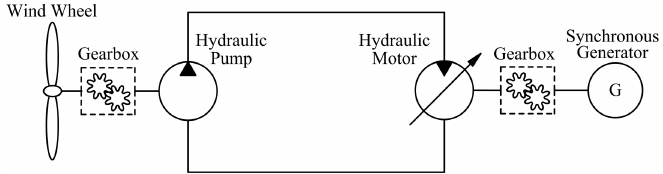
Figure 1. The fundamental principle of the hydraulic wind turbine.